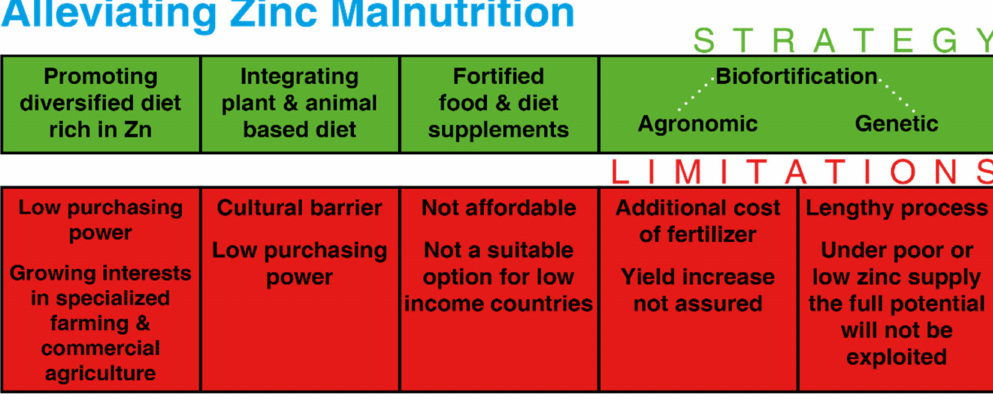
Figure 1. Different strategies for alleviating Zn